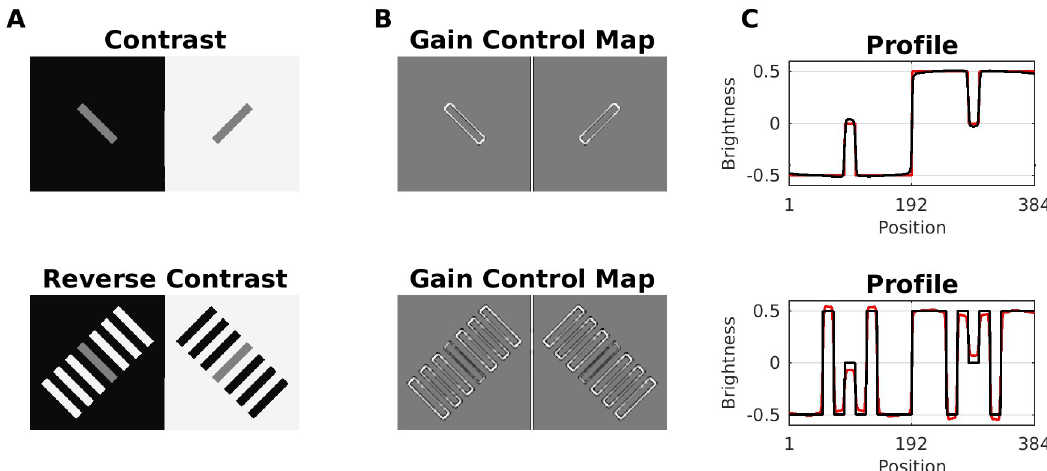
Fig 11. Model prediction for reverse contrast effect. (A) Simultaneous Brightness Contrast (SBC, top) and Reverse Contrast (bottom) which is constructed by adding flanking bars to the SBC configuration. All gray patches have the same luminance. Reverse contrast can be explained either by assimilation with the in-between bars that have the same intensity as the background, or as contrast with the flanking bars that have the opposite luminance to the background. (B) Gain Control Maps obtained by dynamic filtering. Notice the suppression of parallel edges corresponding to flanking patches with the same intensity. (C) Profile plots of predicted brightness (red line) versus luminance (black line).